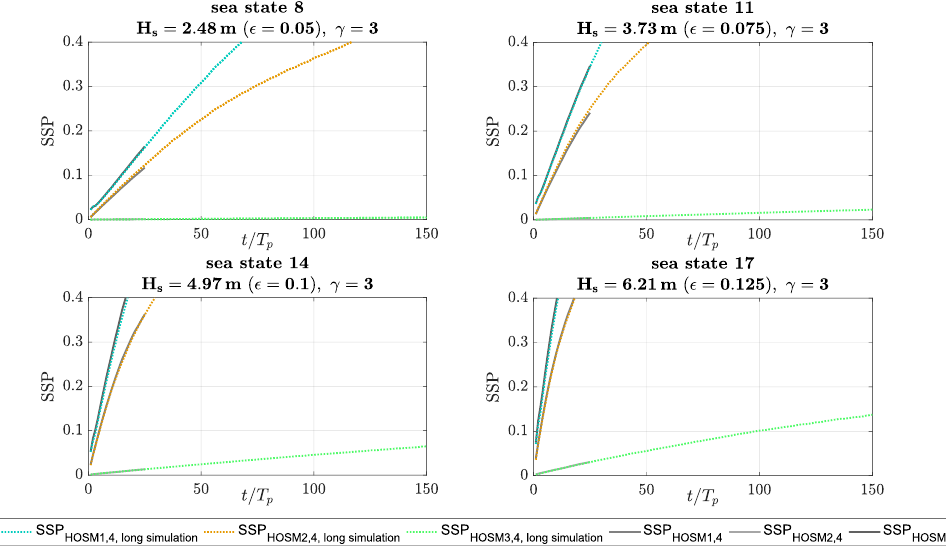
Figure 4. Numerical results: Course of the SSP of long-term simulations for selected sea states (Table 1) for HOSM1 (blue dotted line), HOSM2 (red dotted line), and HOSM3 (green dotted line) and a spreading factors of s = 4. In addition, the respective results shown in Figure 2 are